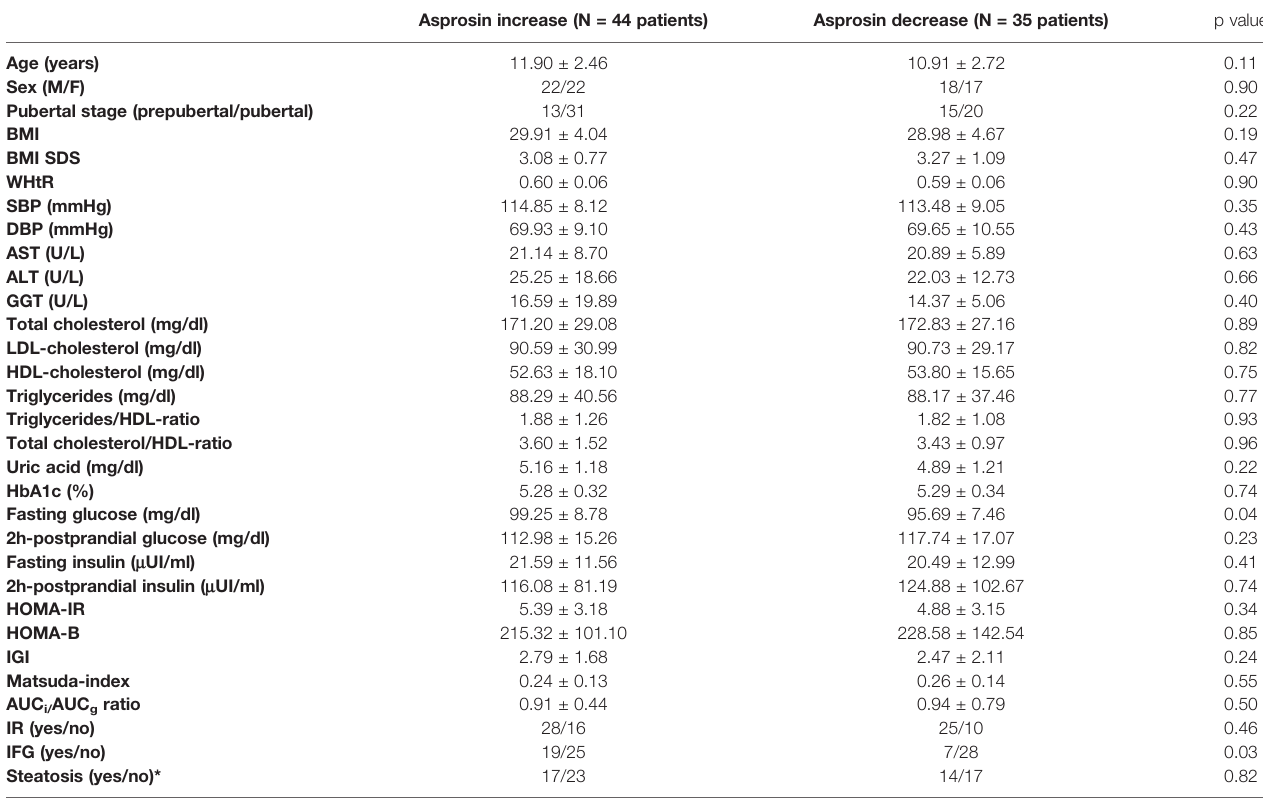
TABLE 3 | Comparison analysis between groups identi fi ed according to meal-related asprosin levels variation.